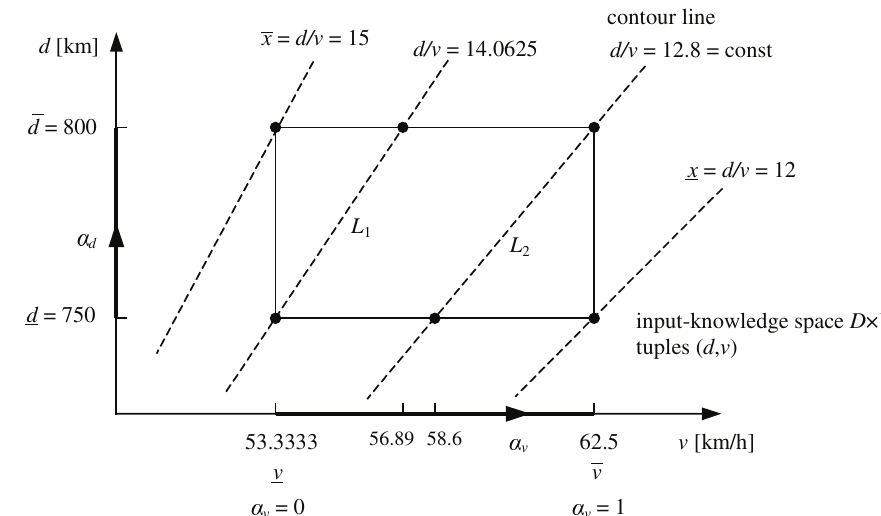
Fig. 5. Illustration of the IPVs division d / v = x with use of the RDM-arithmetic, α d ∈ [ 0 , 1 ] , α v ∈ [ 0 , 1 ] .